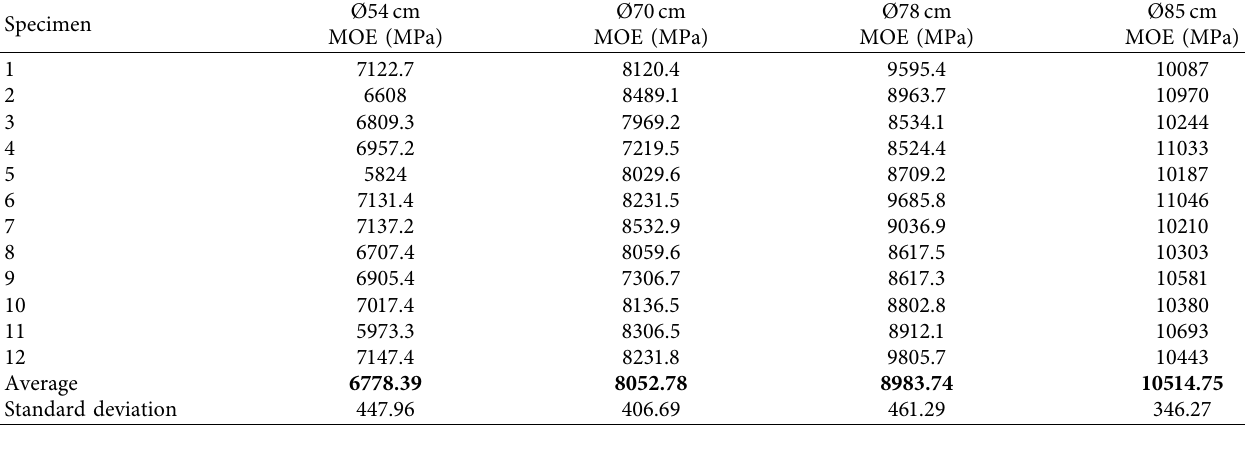
Table 3: Modulus of elasticity per diameter range.